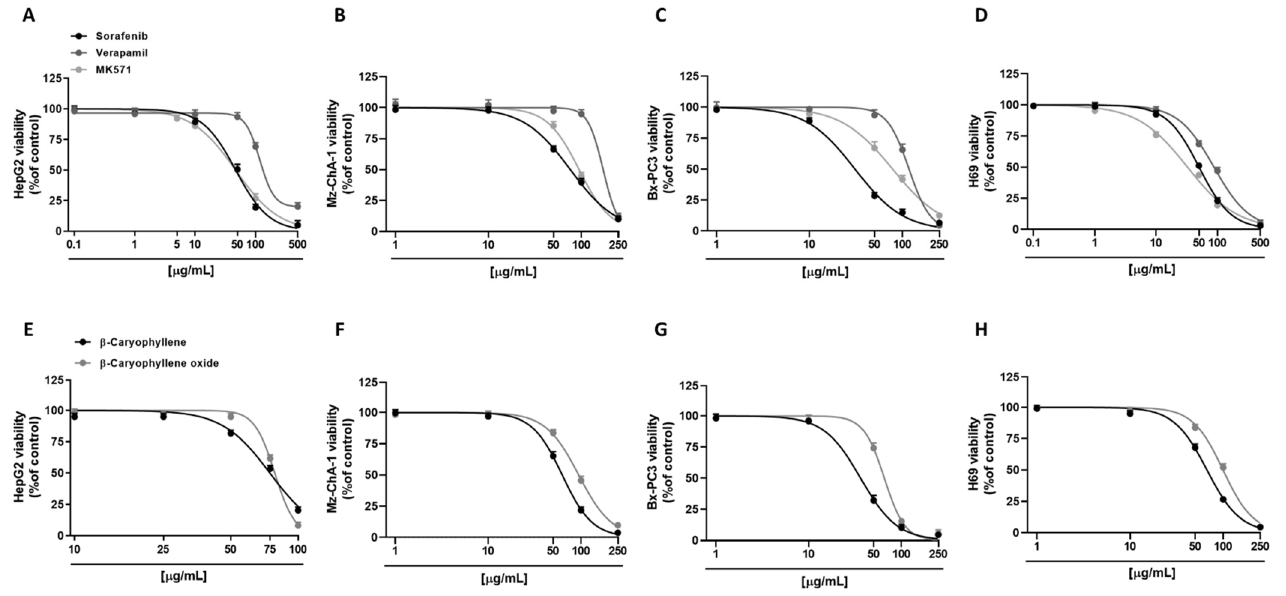
Figure 2. Cytotoxicity effects of sorafenib, verapamil, MK571, and caryophyllane sesquiterpenes β -caryophyllene and β -caryophyllene oxide in hepatoblastoma HepG2 ( A , E ), cholangiocarcinoma Mz-ChA-1 ( B , F ), and pancreatic adenocarcinoma Bx-PC3 cells ( C , G ), and noncancerous H69 cholangiocytes ( D , H ) after 4 h exposure and 72 h recovery time. Data displayed as mean ± SE of at least three independent experiments ( n = 3).